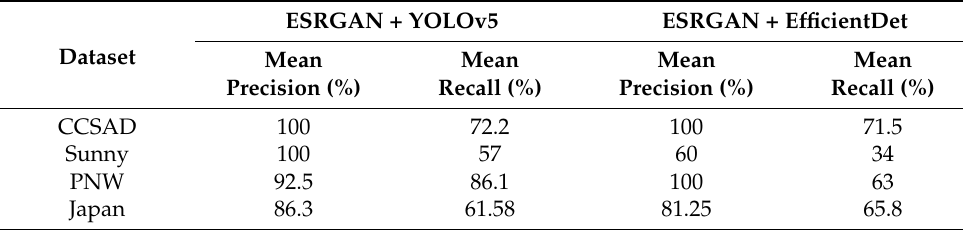
Table 4. Precision and recall on each dataset in the test set for both